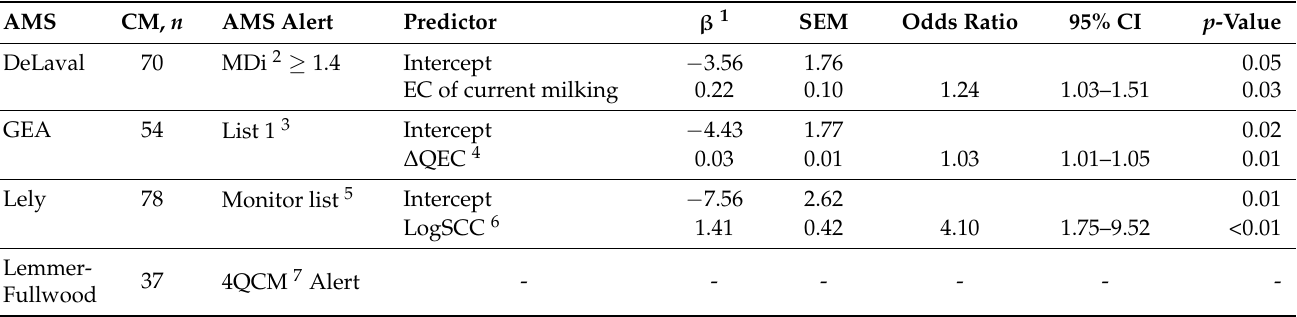
Table 6. Factors improving the sensitivity of clinical mastitis detection (outcome: true positive) in a cow-level multivariable logistic regression analysis including automatically recorded data from AMS and DHIA test days. Only cows with clinical mastitis were used and herd was included as random